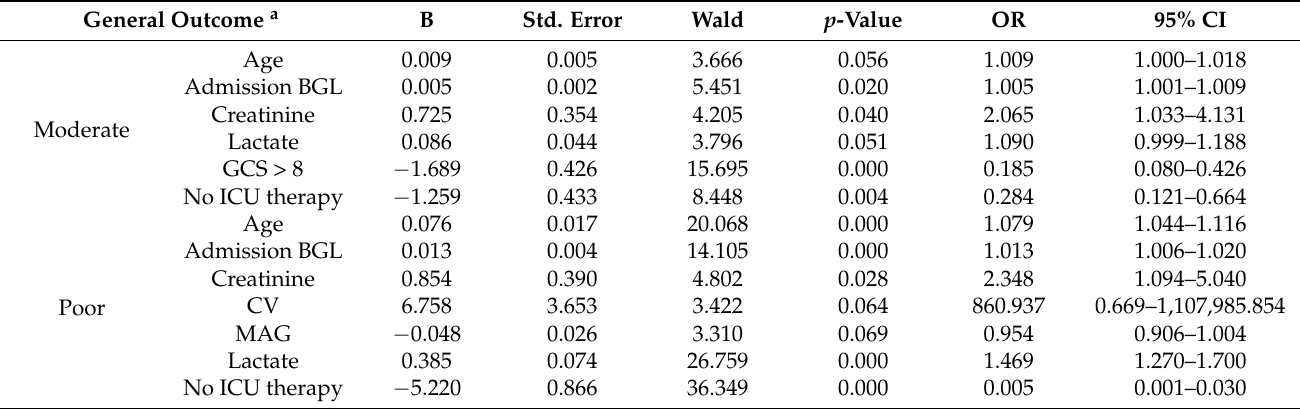
Table 4. The significant variables influencing the outcomes identified after multinomial logistic